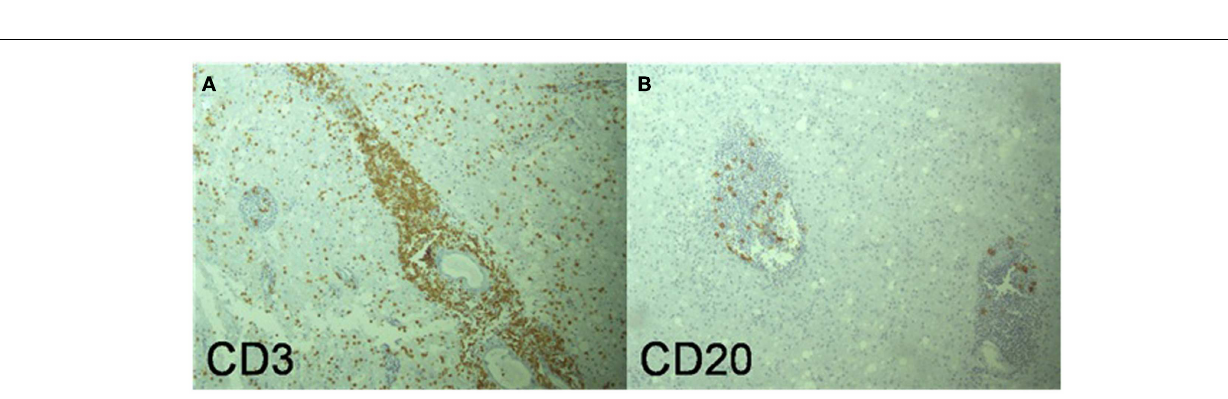
FIGURE 4 | (A) (Medium power magnification) Primarily CD3 positiveT-cell perivascular inflammatory infiltrates with secondary lymphocytic infiltrates in the brain parenchyma. (B) (Medium power) Some CD20 positive B-cells in perivascular area but very few in the surrounding brain